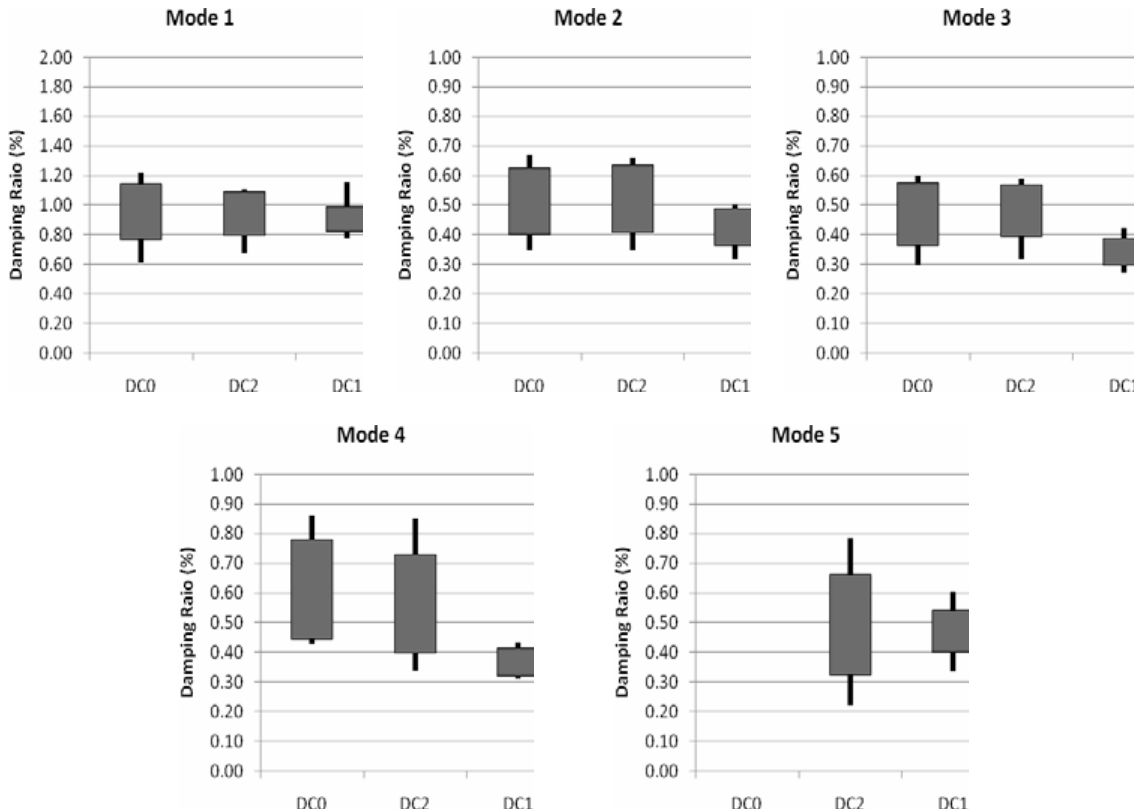
Fig. 18. Evolution of identified damping factors due to damage (OKID) ; solid bars signify µ ± σ range and error bars signify minimum and maximum